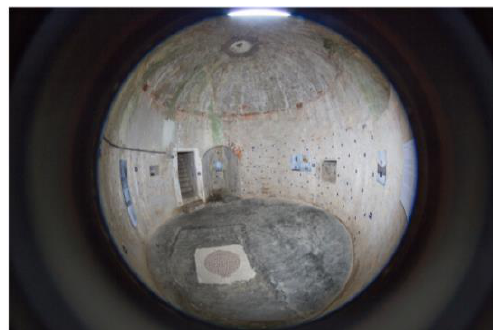
Figure 5. Sample image of the dataset acquired with the fisheye-